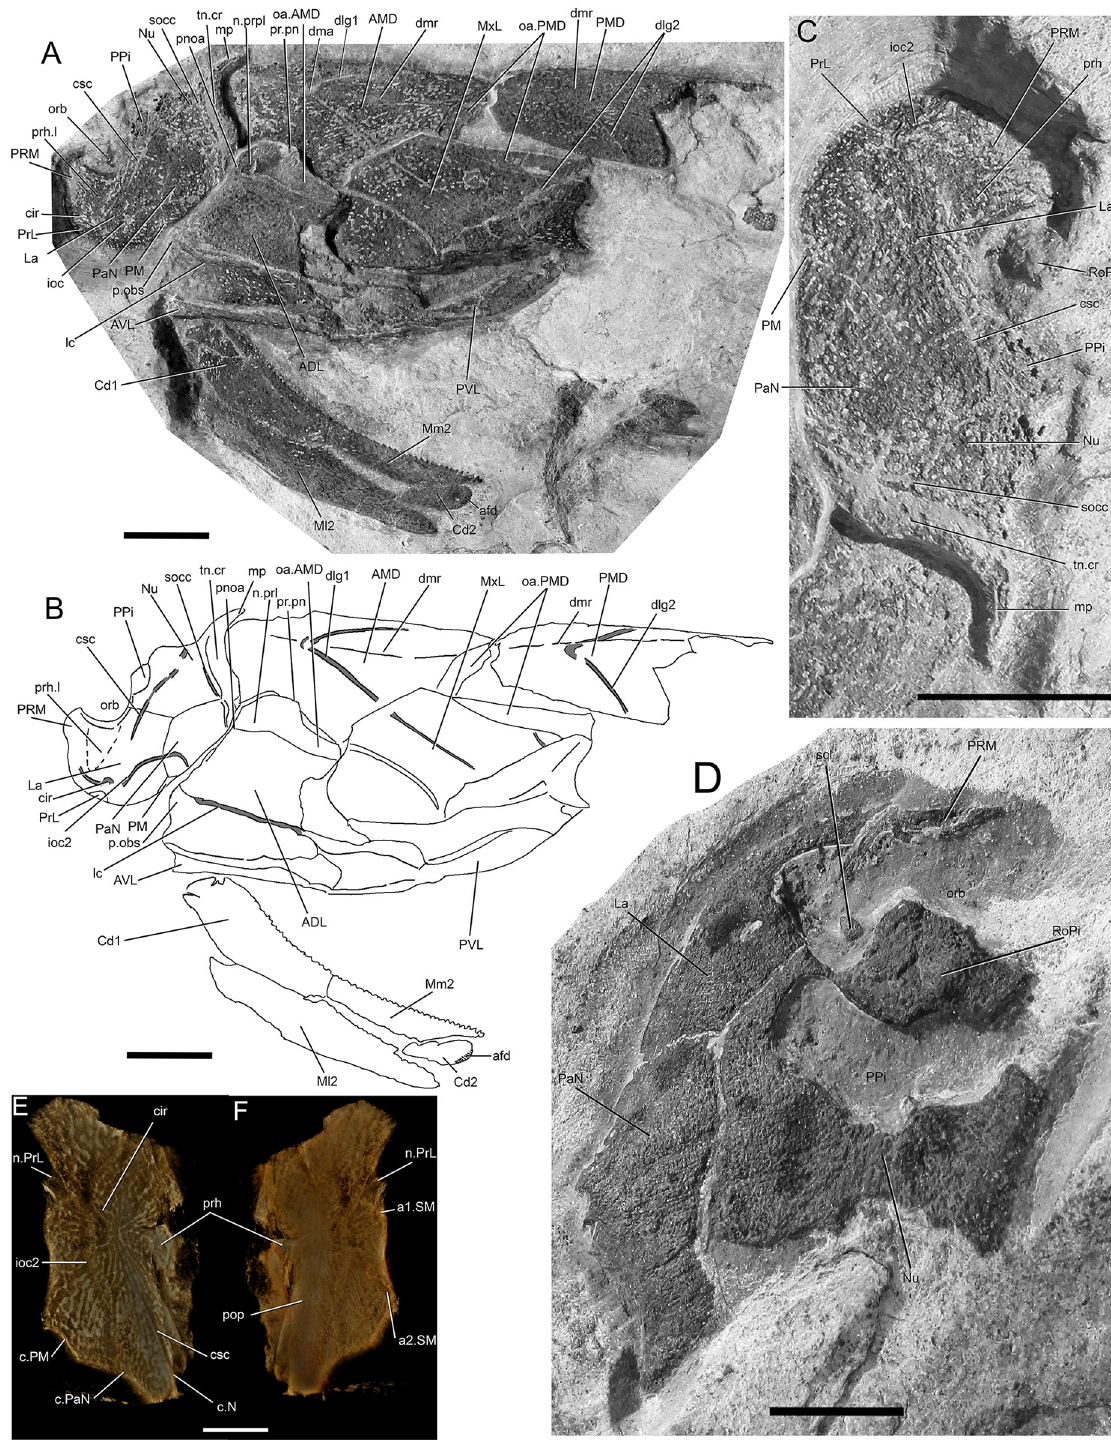
Fig 2. Bothriolepis dairbhrensis sp. nov. A-C. Subcomplete articulated head and body in left lateral view, NMING:F35201 (A, photograph, B, interpretative drawing, C focus on head, rotated 90˚ clockwise). D. incomplete skull roof in dorsal view, NMING:F35202. E-F Left lateral plate in external (E) and internal (F) views, NMING:F35203 (image generated with Dristhi 2.6.6). Scale bars 10 mm.